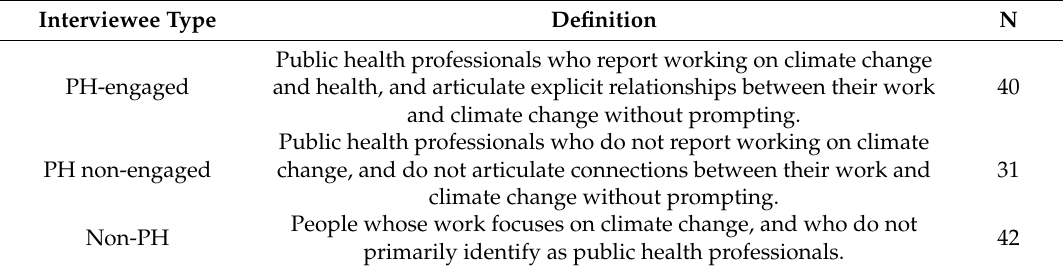
Table 1. Categories and definitions of